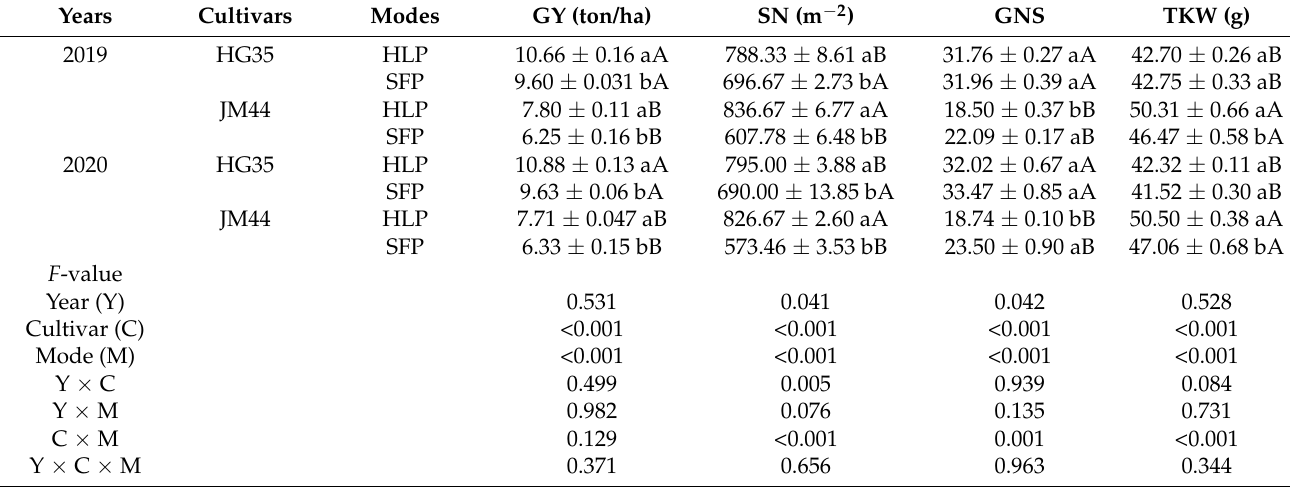
Table 1. Analysis of variance for sowing modes, cultivars, and their interactions on wheat yield and yield